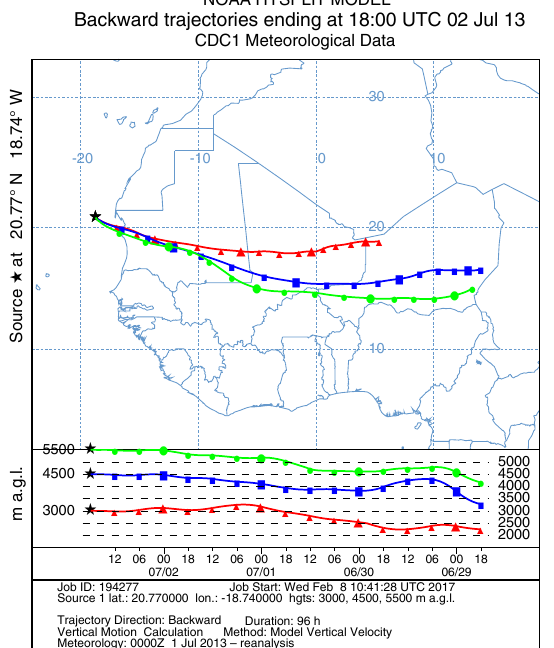
Figure A7. Four-day back trajectories at a height of 3000, 4500 and 5500m on 7 August 2014.